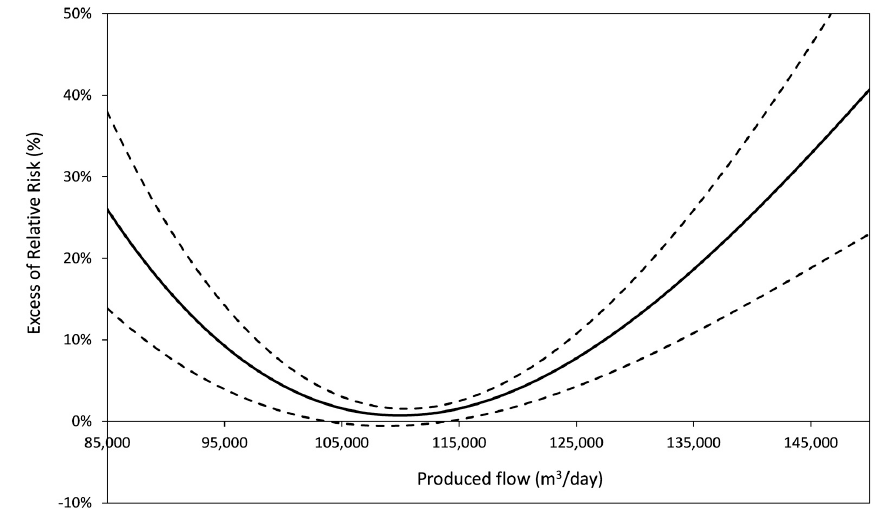
Figure 6. AGE risk function for the produced flow (Nantes). The left branch may miss (e.g., PA and Paris sites). The delay considered for the health response to the river flow is homogenous with that used for turbidity.